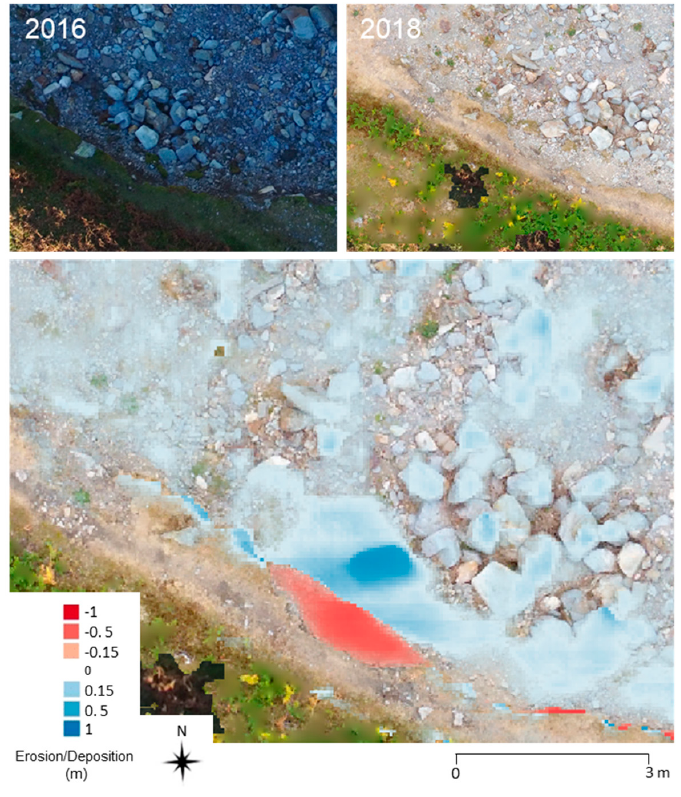
Figure 10. Newly exposed coarse sediment along stripped channel margins on the Liza Beck at Langthwaite.